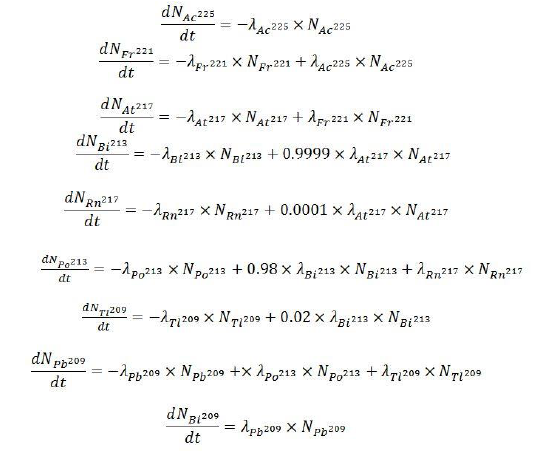
Figure 9. System of equations describing the decay of 225 Ac to the very long-lived 209 Bi.